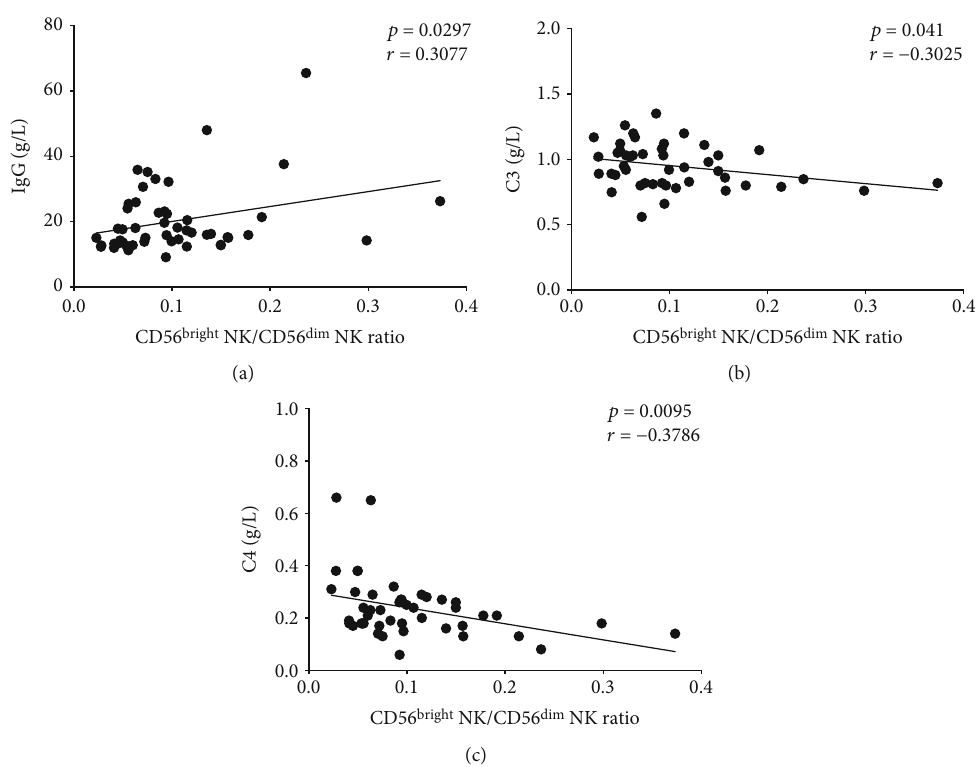
Figure 3: The correlation between CD56 bright NK/CD56 dim NK ratio and disease activity. (a) The correlation analysis between the CD56 bright NK/CD56 dim NK ratio and the serum IgG level or (b) complement C3 level or (c) complement C4 value in pSS